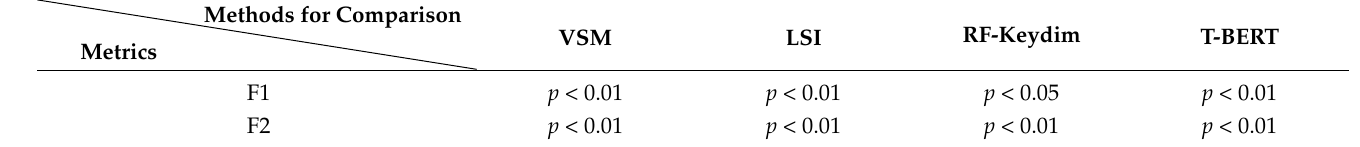
Table 5. Pair-wise Wilcoxon signed-rank test results of the proposed method and baseline methods. Methods for Metrics